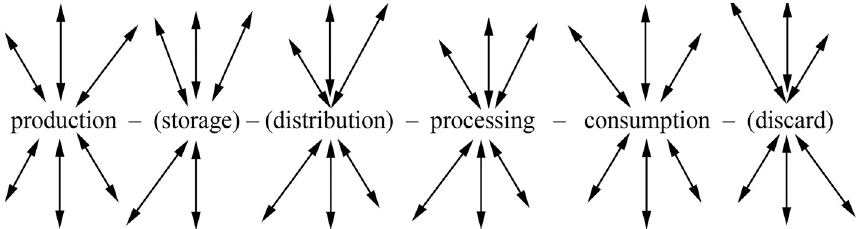
Fig 4. Human-thing interactions along a generalised behaviour chain for food items, basing on a concept brought forward by I. Hodder [62, 63] and adapted to considerations specific to human-food interactions [64–66]. Activities in brackets are facultative and mobile elements, which can take place in virtually any position of the chain. Illustration from Heiss [48].